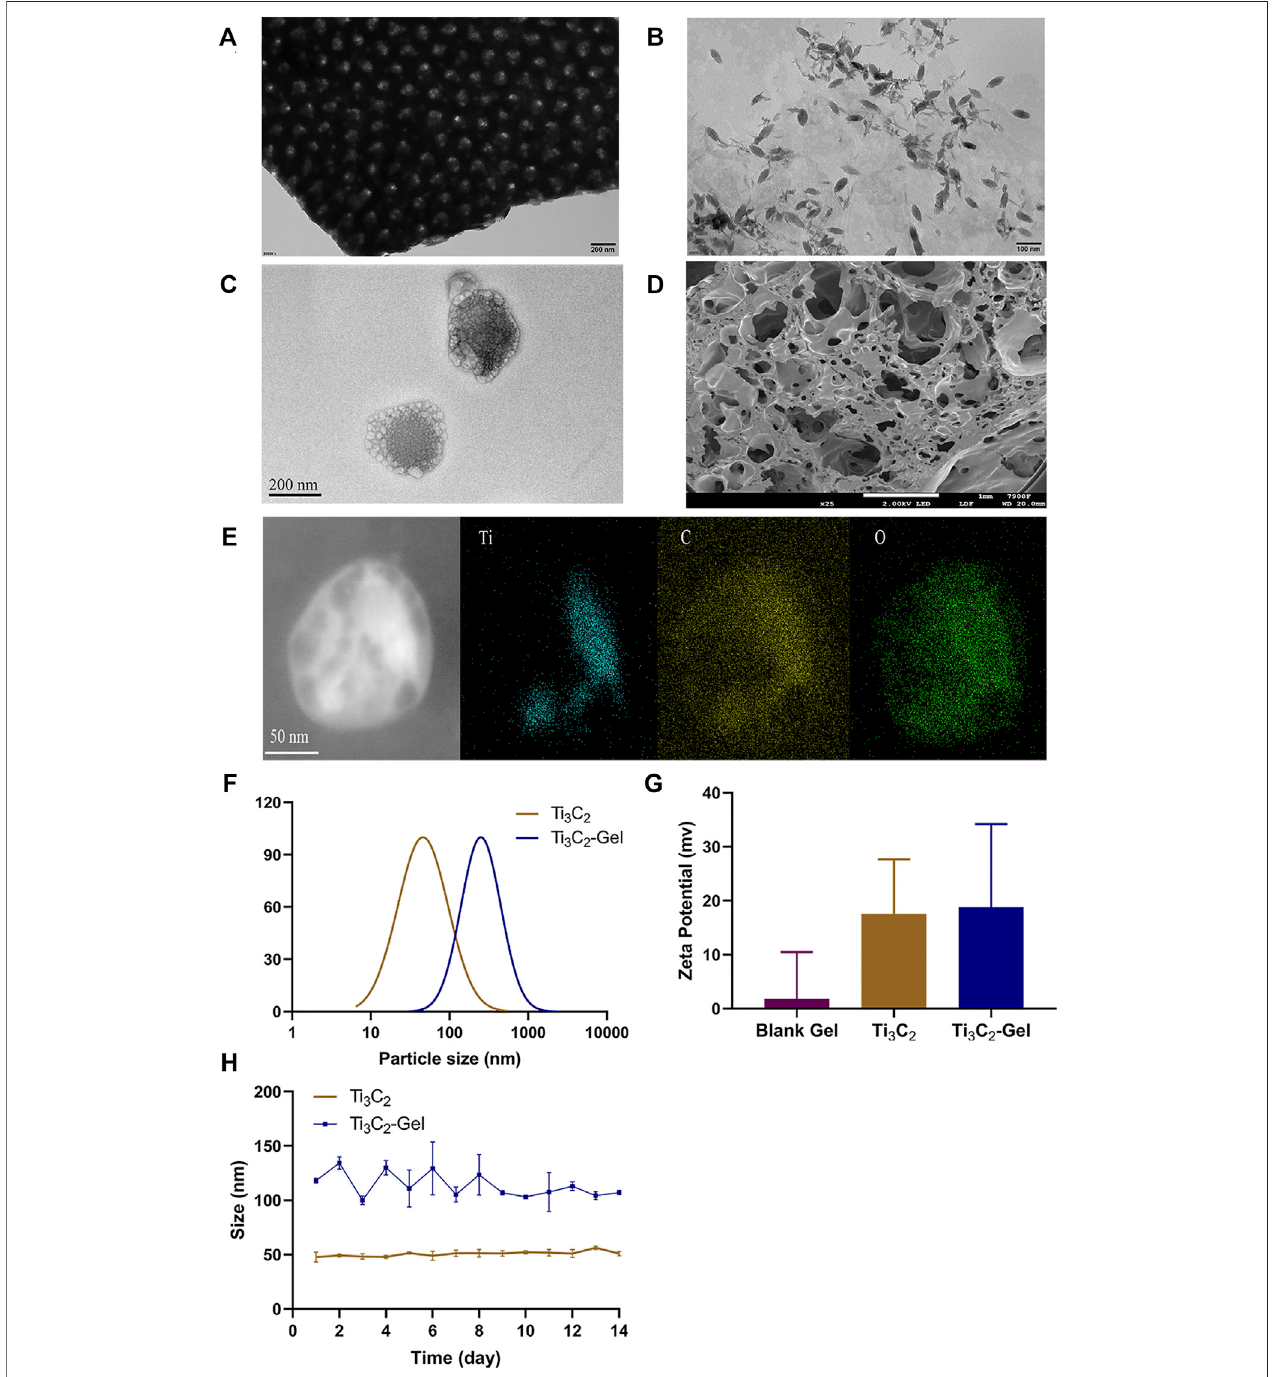
FIGURE2| PreparationandcharacterizationofTi 3 C 2 nanoparticlesandTi 3 C 2 -Gel.Transmissionelectronmicroscopyimageof (A) Ti 3 C 2 MXenesolution(scalebar: 200 nm), (B) Ti 3 C 2 nanoparticles (scale bar: 100 nm), and (C) Ti 3 C 2 -Gel (scale bar: 200 nm). (D) Scanning electron microscopy image of Pluronic F-127 gel (scale bar: 1 mm). (E) Energy-dispersive X-ray image of Ti 3 C 2 -Gel (scale bar: 50 nm). (F) Particle sizes of Ti 3 C 2 nanoparticles and Ti 3 C 2 -Gel. (G) Zeta potentials of the different preparations. (H) Stability of Ti 3 C 2 and Ti 3 C 2 -Gel sizes.